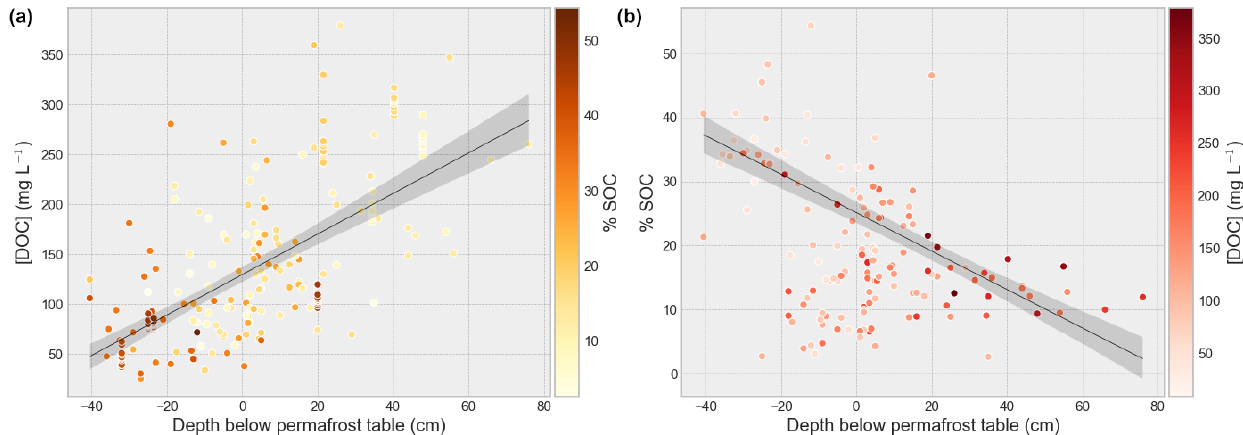
Figure 7. DOC concentration (mgL − 1 ) vs. depth to the permafrost table (cm; a ) and SOC content (% of dry weight) vs. depth to the permafrost table (cm; b ), where a negative value indicates samples within the active layer and a positive one indicates samples below the permafrost table. Colors of the dots show SOC percentage and DOC concentration, respectively, and show the inverse correlation between soil organic carbon content and DOC concentration over the depth of the soil profile. We observe elevated DOC concentrations corresponding with low SOC content around the permafrost table, which may be an effect of flushing in from the overlying Oi horizons and accumulation above the permafrost table. Linear regression of DOC with depth respective to permafrost table in centimeters (i.e., active-layer depth Z AL ) yields [ DOC ] = 2028 · Z AL + 13460, R 2 = 0 . 71, p = 8 . 6 × 10 − 37 and SOC % = − 0 . 3 · Z AL + 2515, R 2 = 0 . 55, p = 1 . 04 × 10 − 19